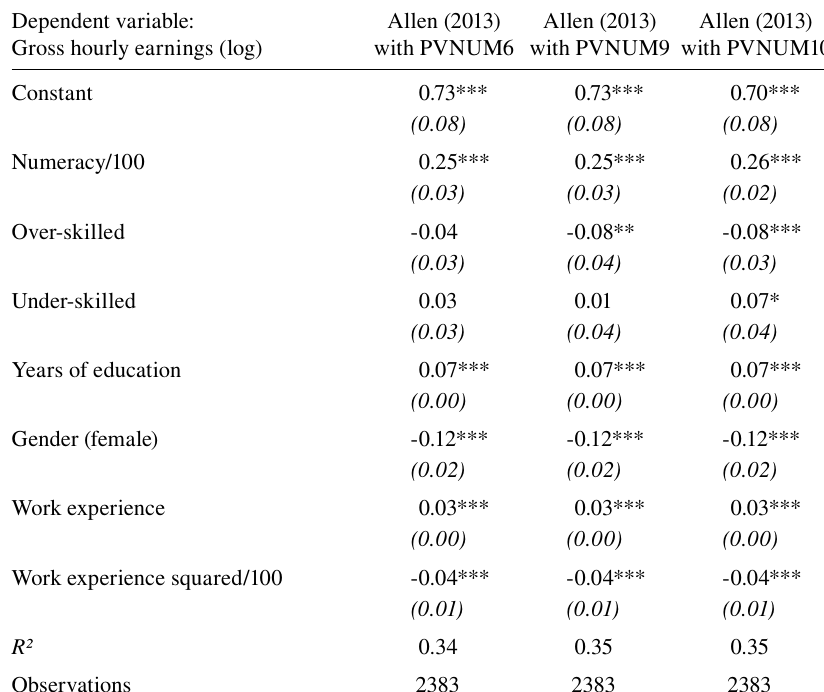
Mincer regressions with skill-mismatch according to Allen et al. (2013) with three different plausible